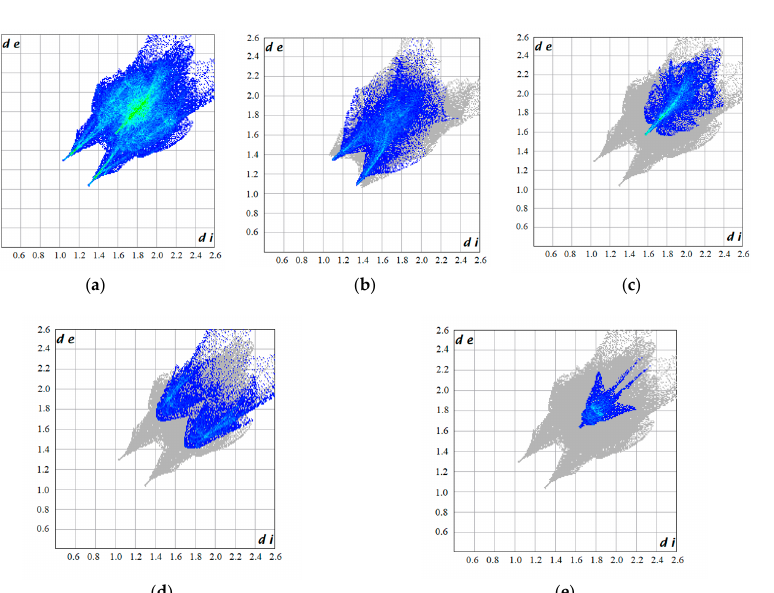
Figure 2. 2D fingerprint plots ( a ) and sections of the graph, which correspond to H···F ( b ), F···F ( c ), C··· F ( d ) and C···C ( e ) interactions in the structure 1 .